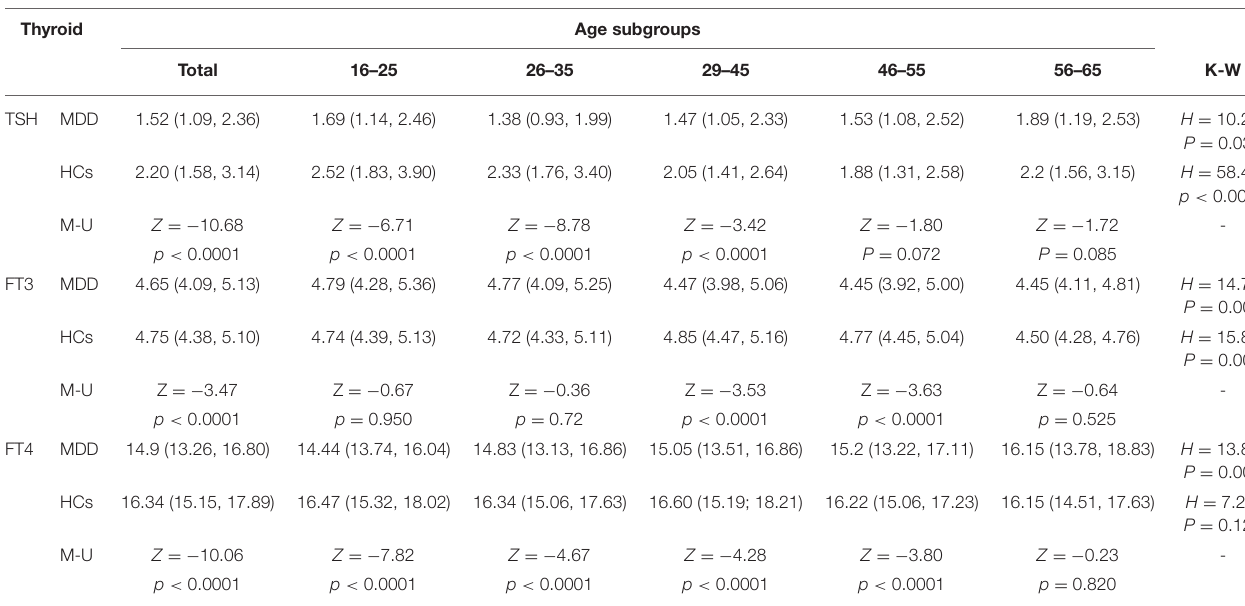
TABLE 2 | Median and quartile of thyroid hormones levels in age